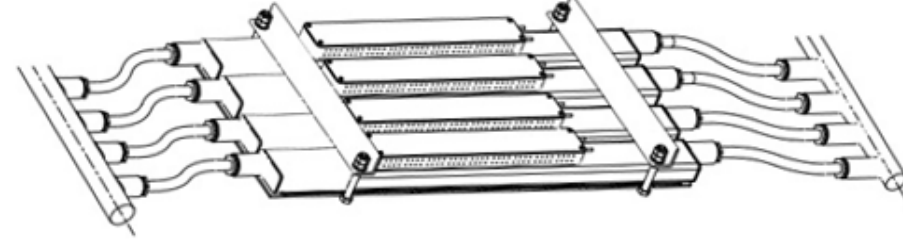
Figure 7. Gas cooling module using the thermoelectric converter.